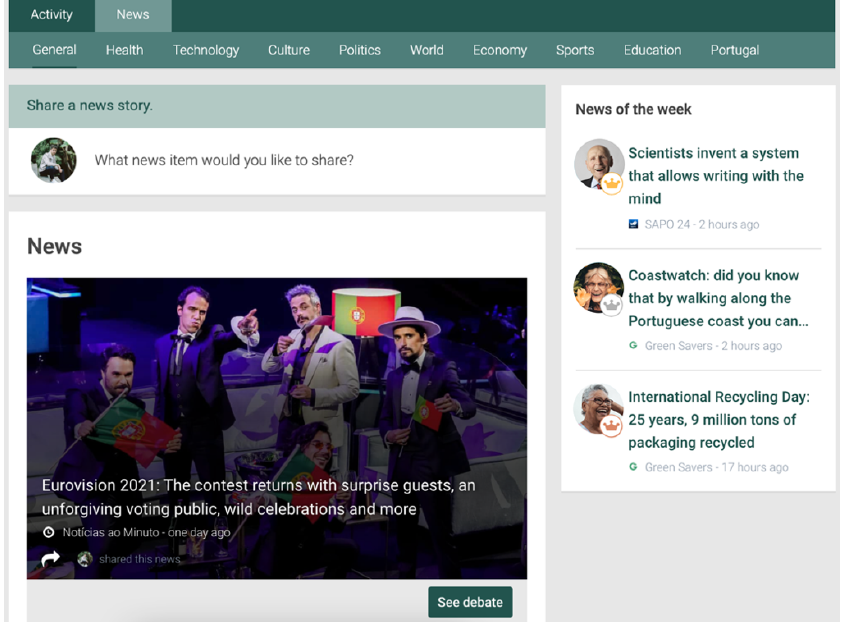
Figure 7. Modal of leveling up to the Explorer level (Authors’ copyright).